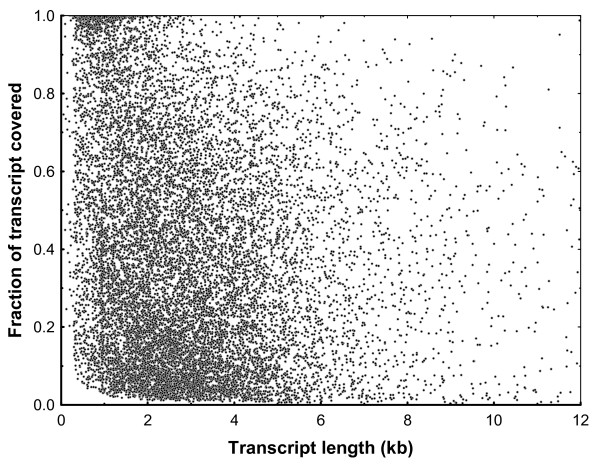
The relationship between the transcript length and transcript completeness. The relationship between the mouse transcript length and the fraction of transcript covered by the bank vole sequences. For computation of R2 (0.077, P < 10-4) transcript length was log-transformed and fraction covered arcsin square root transformed, but the plot shows, for clarity non-transformed data and only transcripts up to 12 kb.